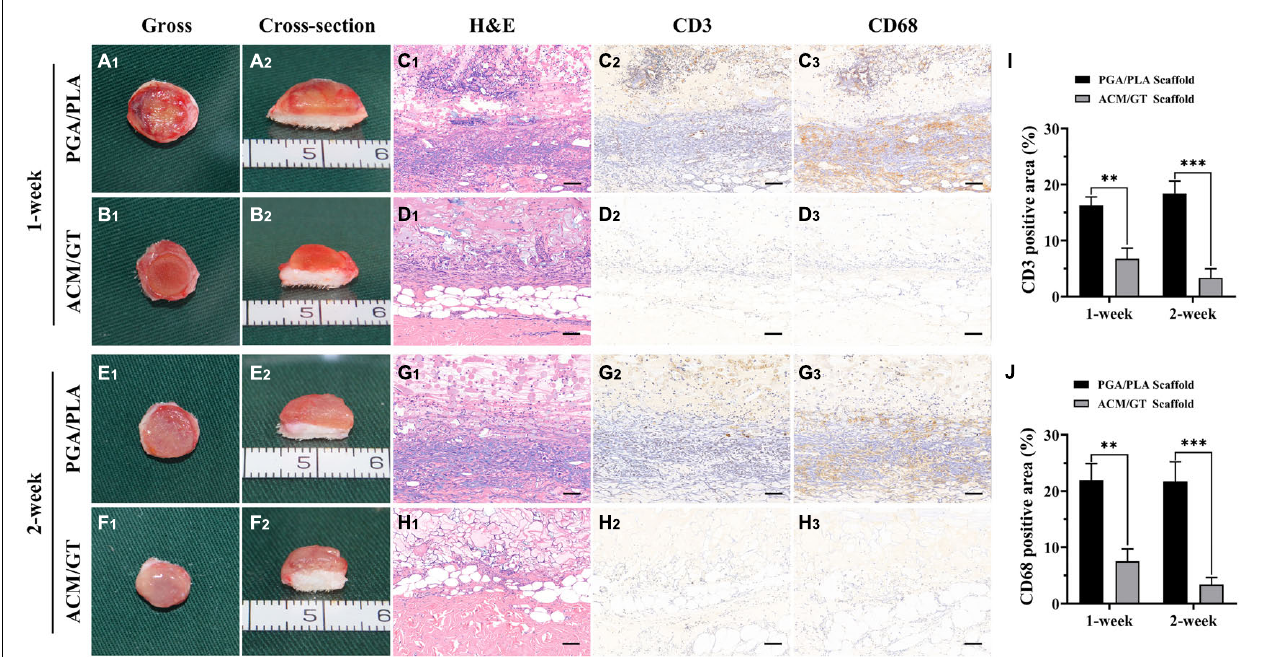
FIGURE 3 | The immune-inflammatory response evaluations of the scaffolds subcutaneously implanted for 1 and 2 weeks. Gross and cross-section observation of the PGA/PLA scaffold and ACM/GT scaffold which subcutaneously implanted for 1 week (A,B) and 2 weeks (E,F) . Two groups of implanted samples with surrounding tissue were stained with H&E, CD3, and CD68 for immune-inflammatory response analysis (C,D,G,H) and the quantification of the CD3 (I) and CD68 (J) position area (%). Scale bar: 100 µ m. Statistical significance: ∗∗ p < 0.01, ∗∗∗ p < 0.001.